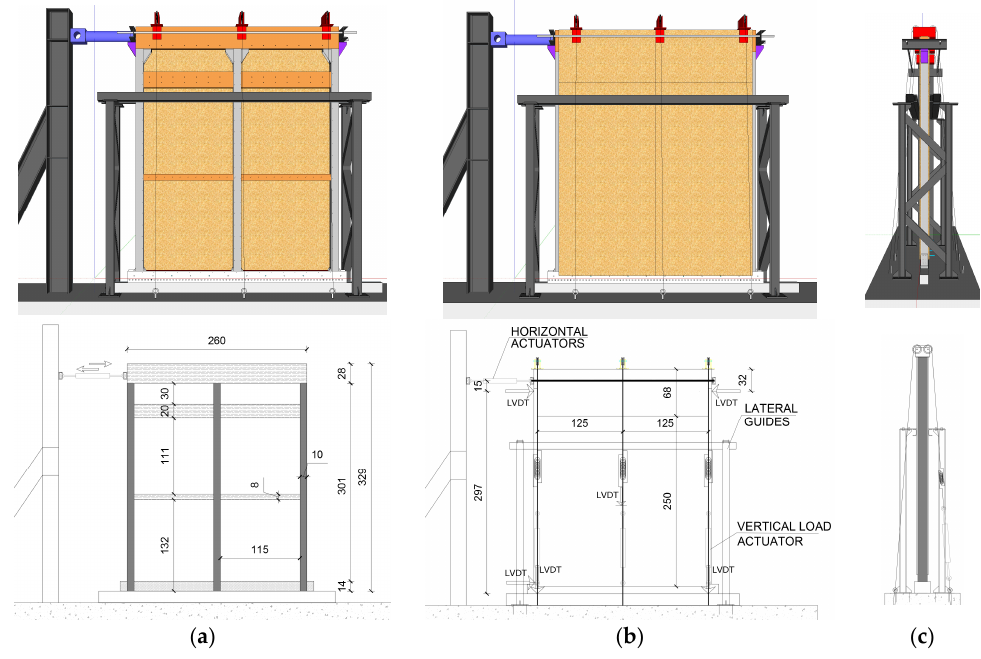
Figure 5. Specimen and test setup: ( a ) inner view; ( b ) external view and setup; ( c ) side view. (Dimensions in cm).